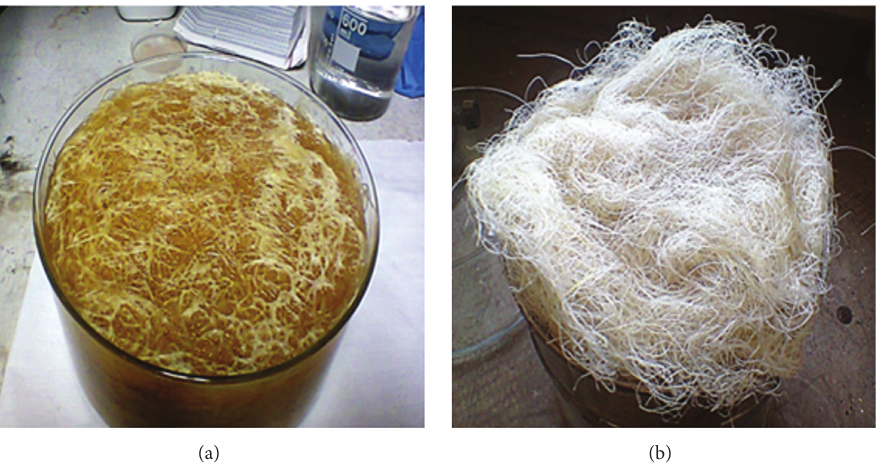
Figure 1: Pictorial images of surface modification of sisal fiber: (a) during treatment and (b) after treatment and cleaning/washing.